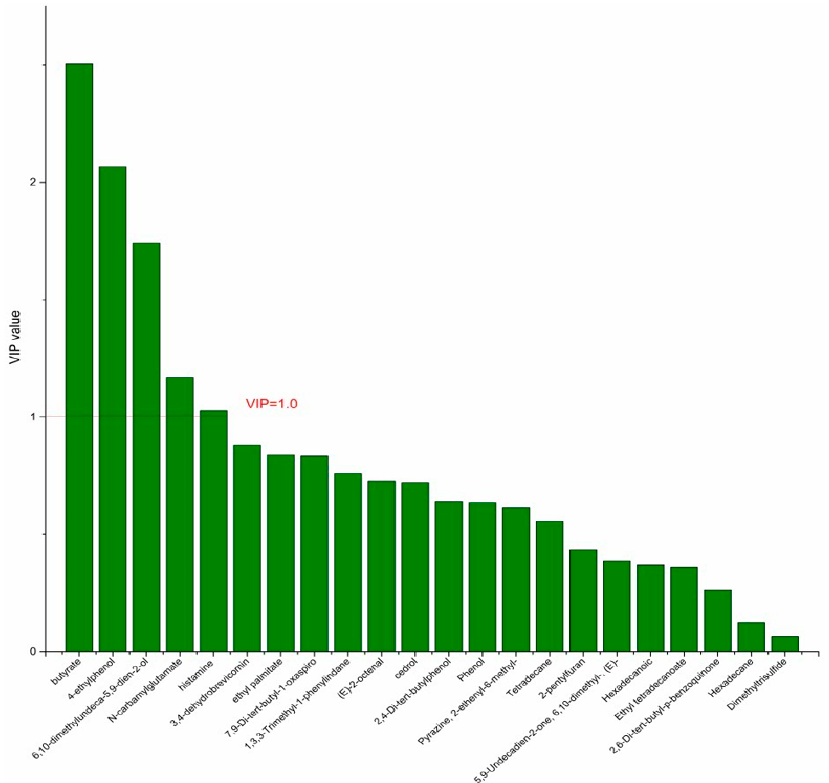
Figure 10. The VIP plot of the differential bacterial metabolites in DPA group vs. EPA group.